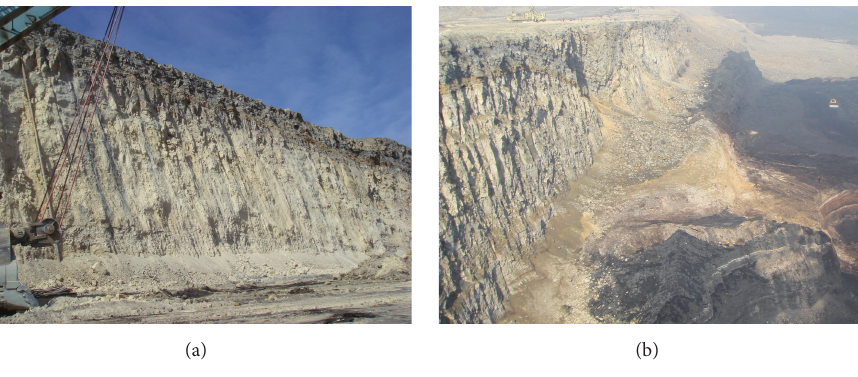
Figure 14: Presplit blasting effect of HSCM.